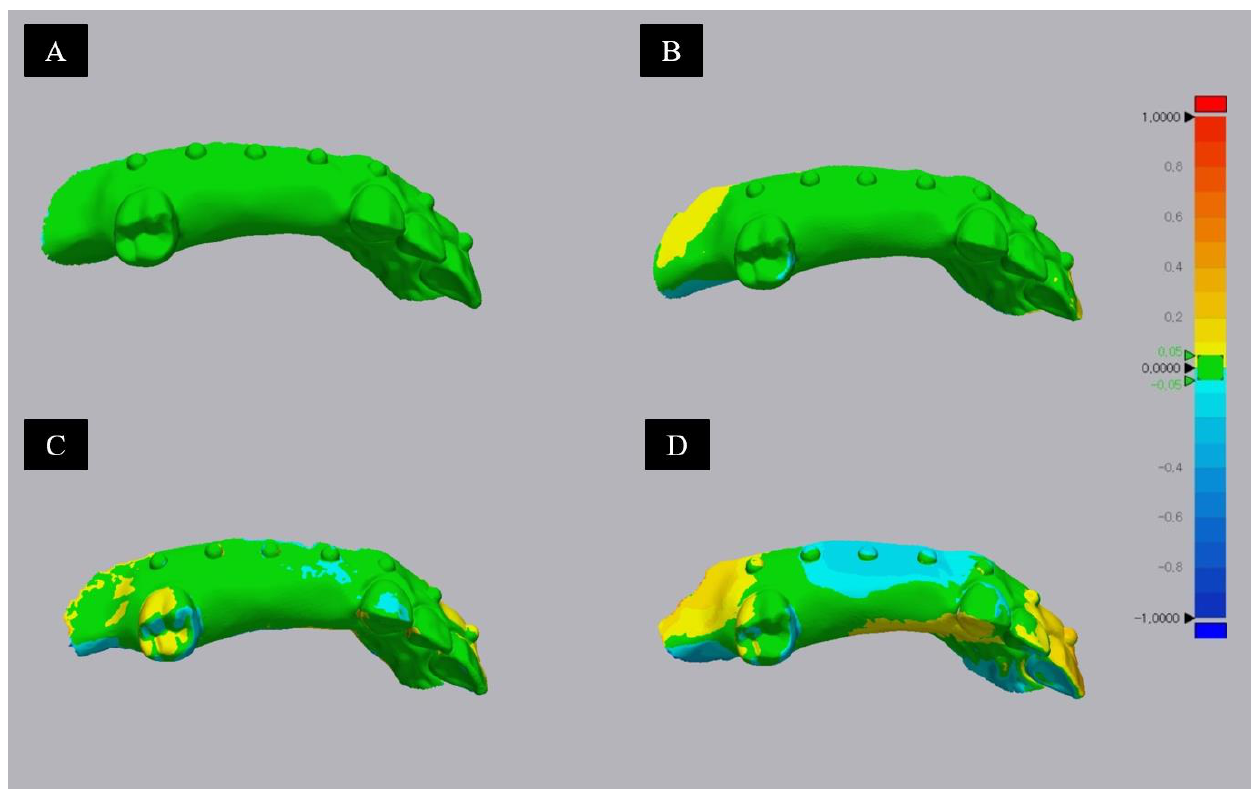
Figure 5. Representative images of a color map for assessing the precision of the laboratory scanner and IOS. ( A ) T500, ( B ) Trios 3, ( C ) CS3600, ( D ) i500. In T500, there is almost no deviation. Trios shows a slight deviation on the occlusal surface. In CS3600, the positive deviation is observed on the occlusal surface of the second molar. In i500, the positive deviation is observed on the cingulum surface of the canine and the occlusal surface of the second molar. In color map analysis, maximum range was 1.0 mm, minimum range was 1.0 mm and tolerance level was ±0.05 mm.